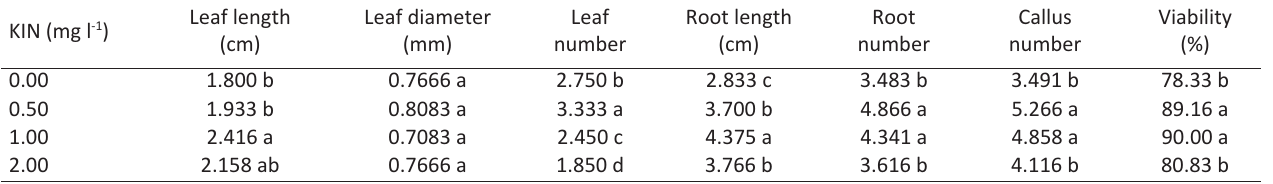
Table 2 ­ Mean comparison of the effect of different concentrations of KIN on measured characters of Fritillaria imperialis L.